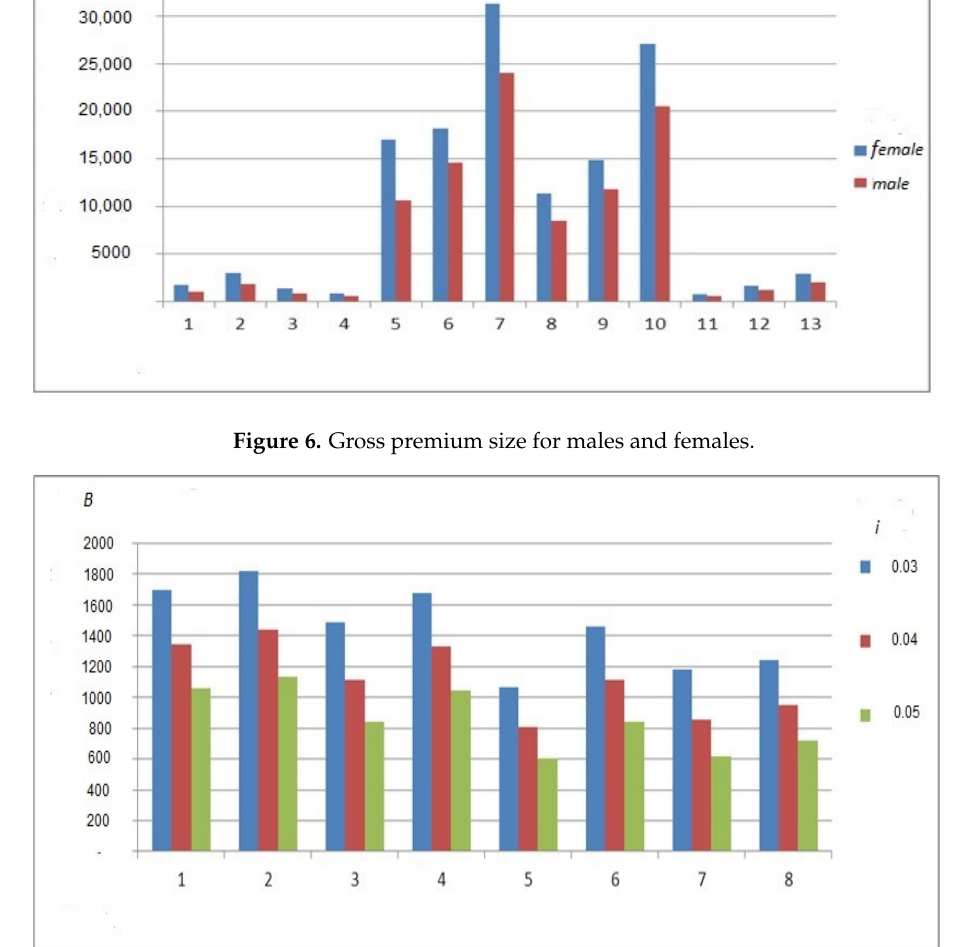
Figure 7. Gross premium size as a function of the interest